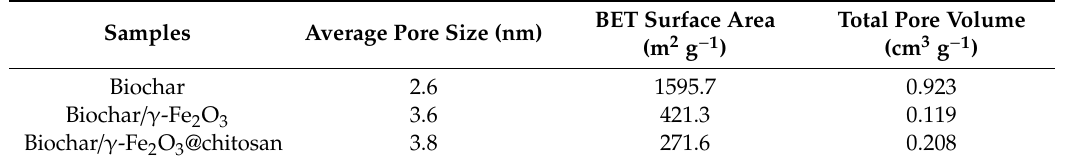
Samples Average Pore Size (nm) Samples